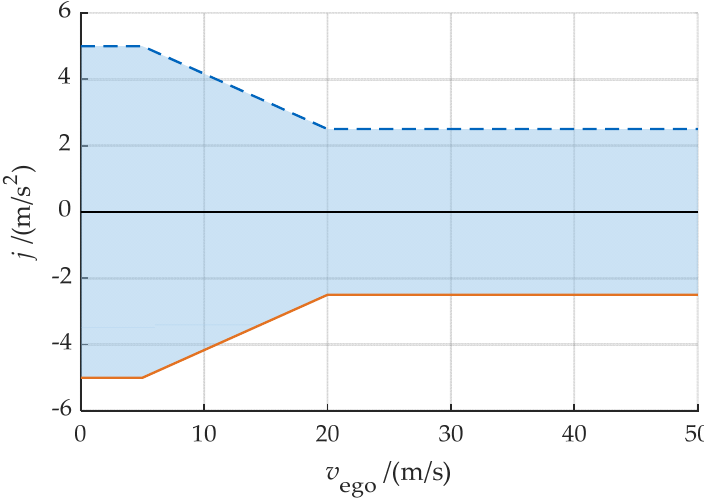
Figure 11. Upper and lower limits of jerk based on [55].